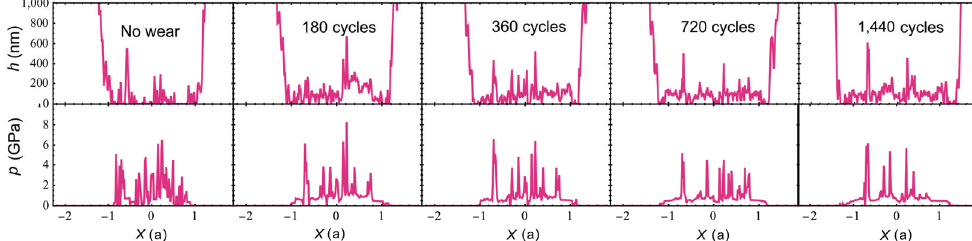
Fig. 8 2D view of h (top) and p evolutions